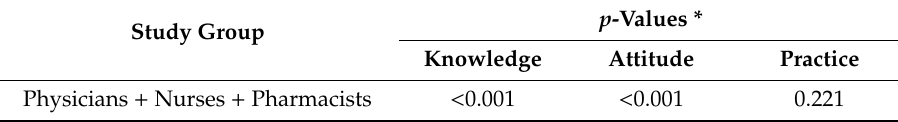
Table 6. Intergroup analysis. (Jonckheere–Terpstra trend test) Study